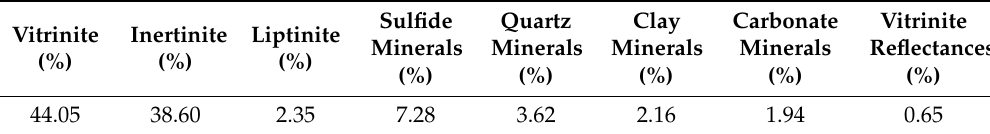
Table 2. Characteristic parameters of coal